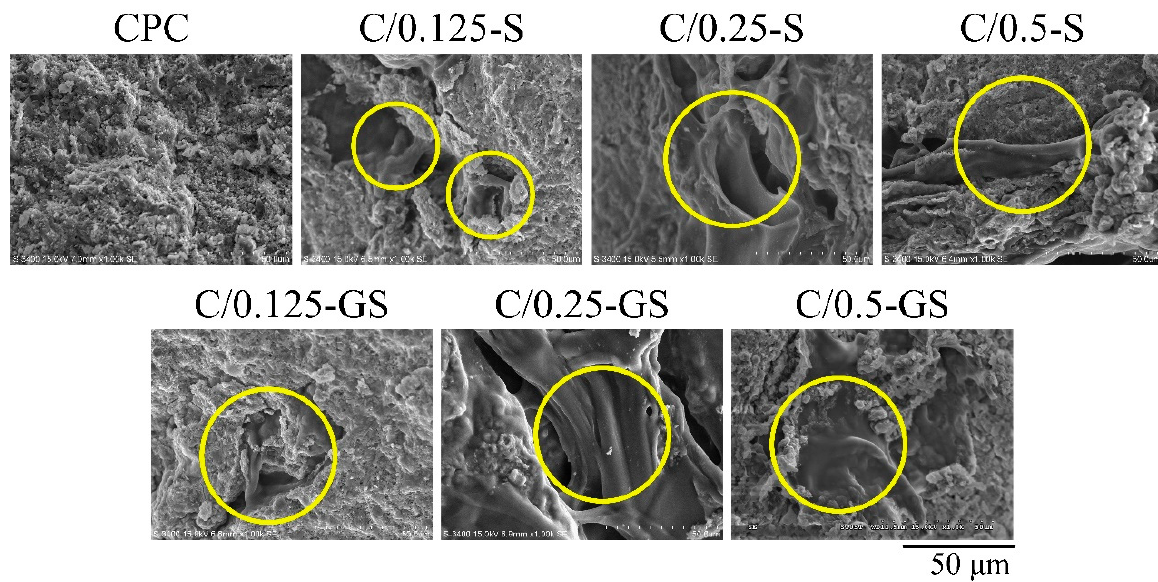
Figure 3. SEM fracture analysis of CPC/hydrogel composites immersed in Tris-buffer solution for 1 day. Images inside the yellow ring show that the composites contain a hydrogel.